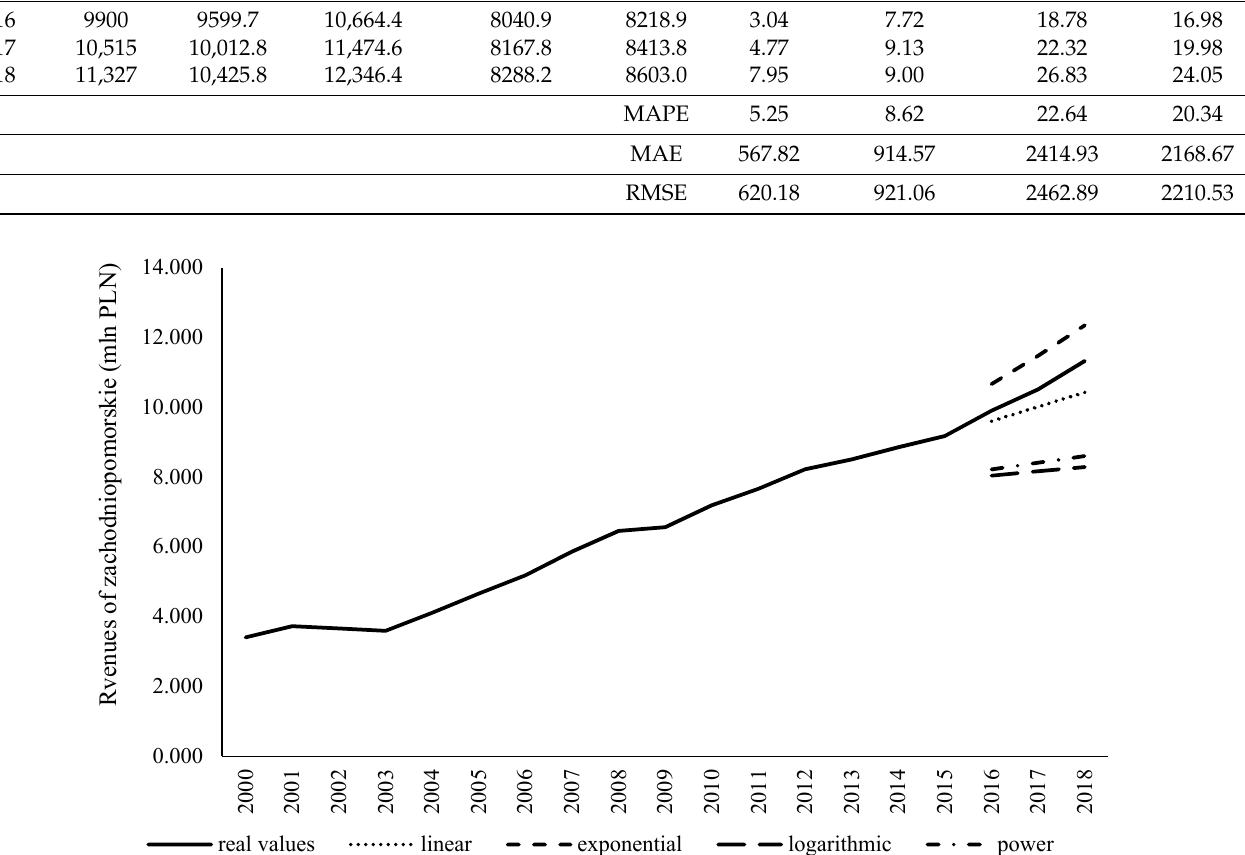
Figure 1. Real values (2000–2018) and forecasts (2016–2018) of revenue of Zachodniopomorskie voivodeship (trend models).